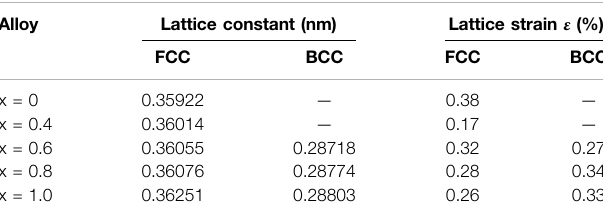
TABLE 4 | Lattice parameters, lattice strain and phase fraction of FeCoNi(CuAl)x MEA and HEAs.